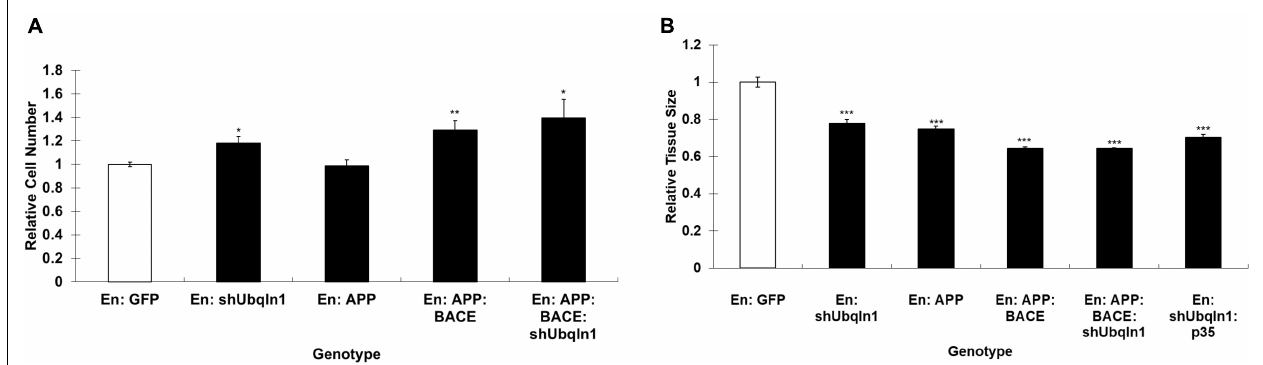
FIGURE 2 | Effects of Drosophila ubqn on cell number (A) and growth (B) in the wing. The UAS constructs were expressed in the posterior domain of wings, and analyzed for the difference in cell number between the posterior (P; experimental) and anterior (A; control) compartments. For each genotype, five independent wing compartments were assayed (A) . Total cell number for each genotype included: En: GFP (A: 300, 318, 327, 293, 363; P: 480, 566, 542, 499, 569); En: shUbqln1 (A: 275, 342, 318, 351, 317; P: 624, 651, 647, 572, 624); En: APP (A: 380, 355, 305, 270, 335; P: 550, 545, 500, 537, 532); En: APP:BACE (A: 256, 310, 318,